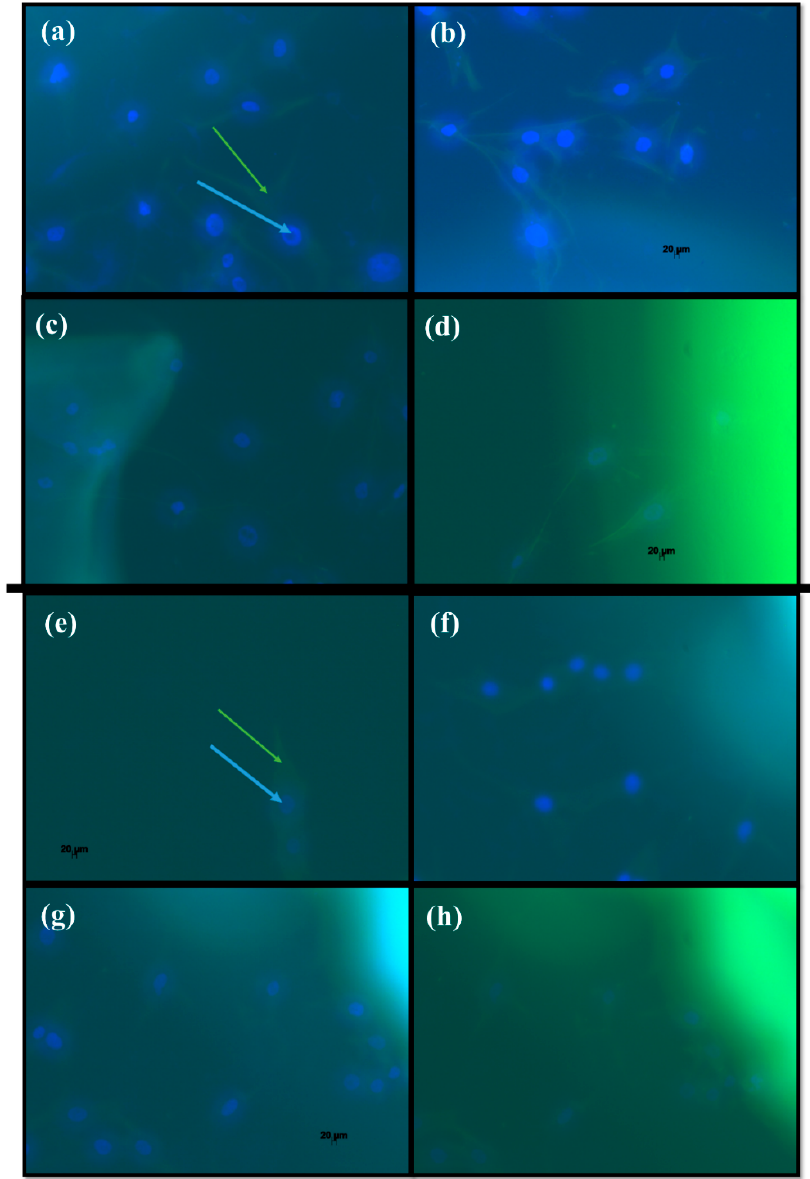
Figure 6. Fluorescence cell imaging: Alexa Fluor 488 conjugated to phalloidin and DAPI targeting actin (green arrow) and nuclear DNA (blue arrow) for cell-CS-DNA ( a – d ) and CS-P ( e – h ) contact, respectively.